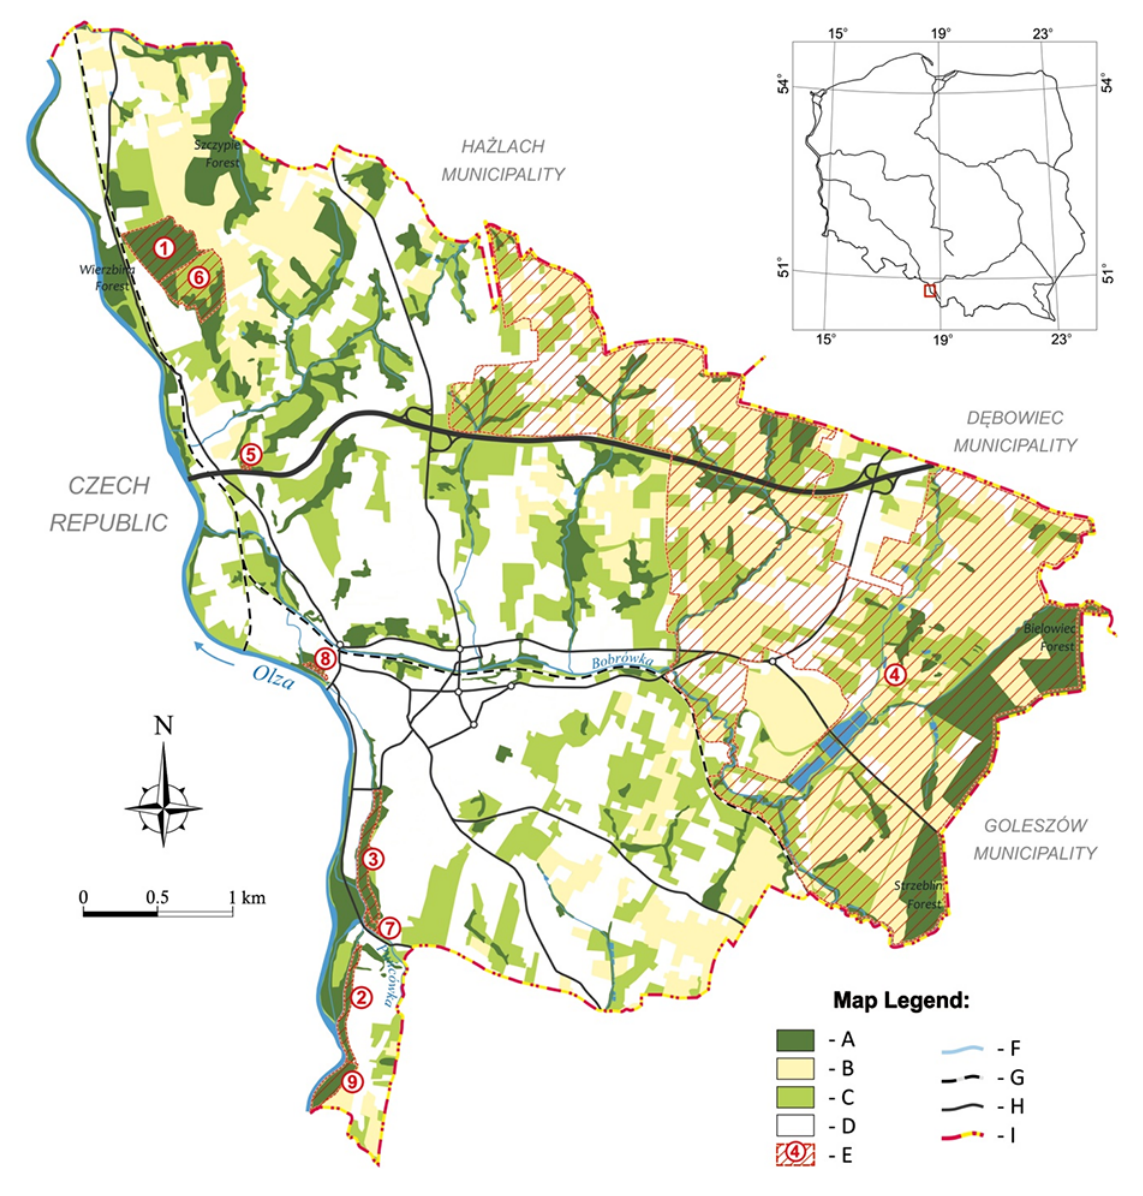
Figure 1 Map of Cieszyn municipality area. A – forests and tree stands; B – farmlands; C – meadows, pastures, orchards, and allotments; D – urbanized areas (industrial, service, and residential buildings); E – areal form of nature protection; F – surface water (streams, rivers, and ponds); G – railway; H – roads; I – commune border: 1 – “Kopce” nature reserve; 2 – “Lasek